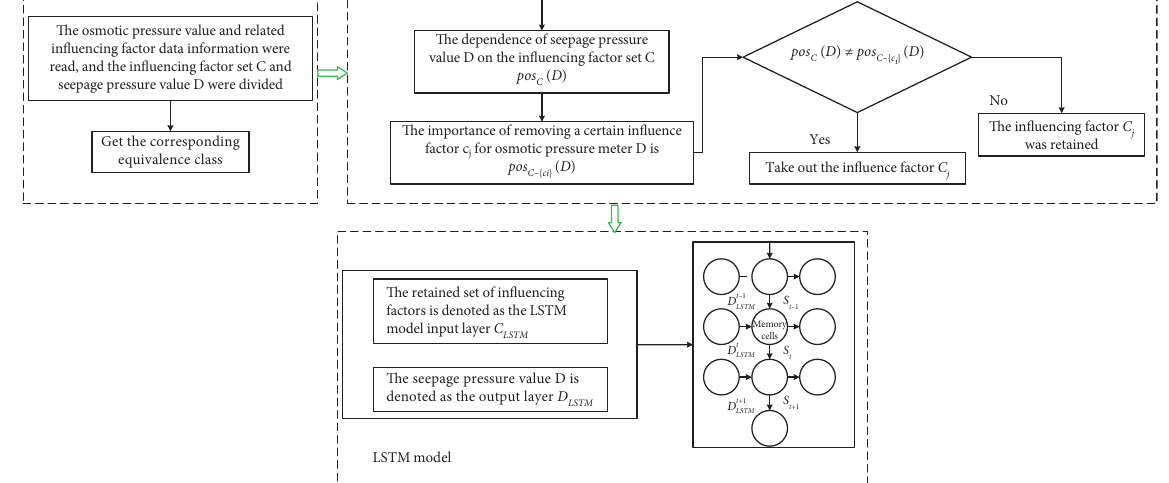
Figure 5: Prediction flowchart of the RS-LSTM model.